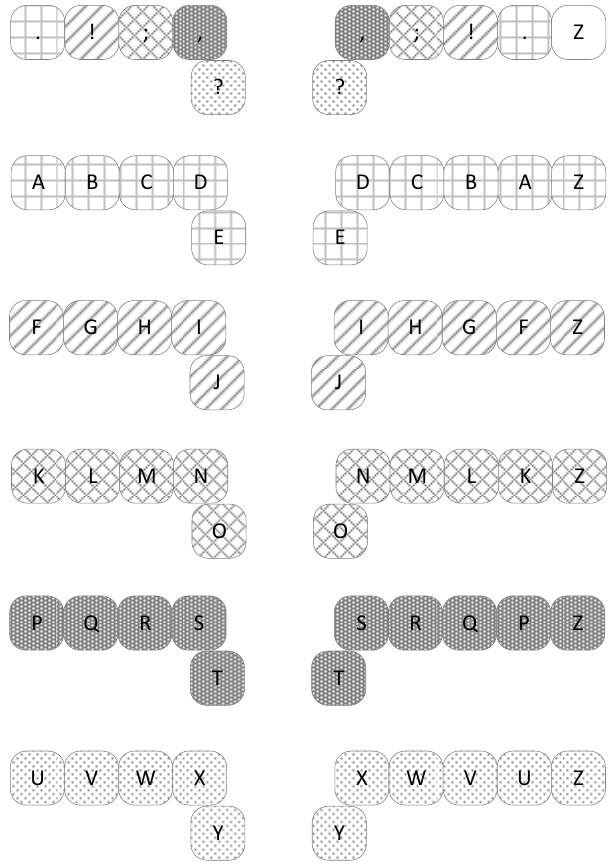
Figure 8. ABC-W-ORK+ arrangement.